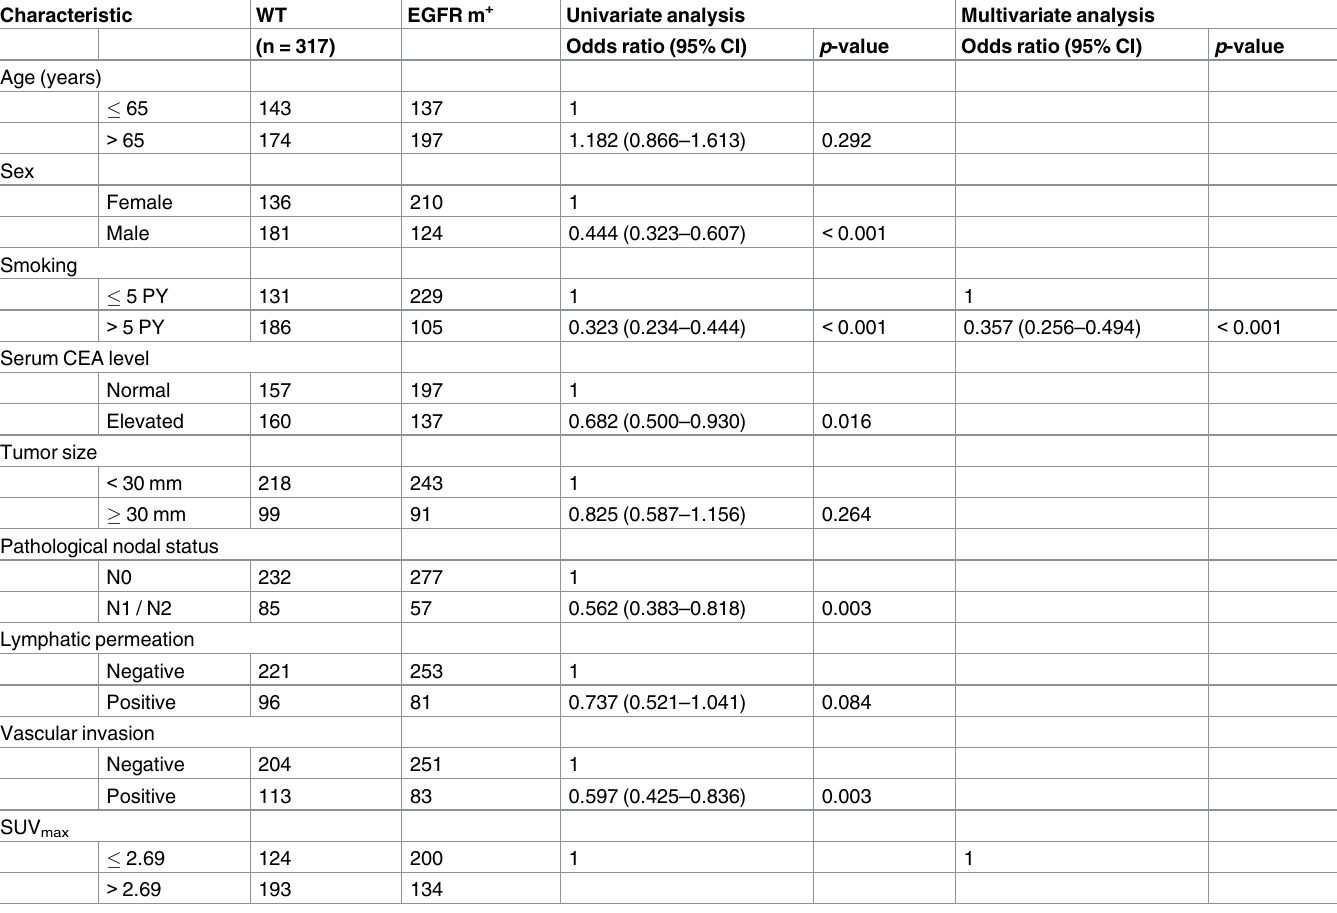
Table 2. Univariate and multivariate analysis of predictors of EGFR